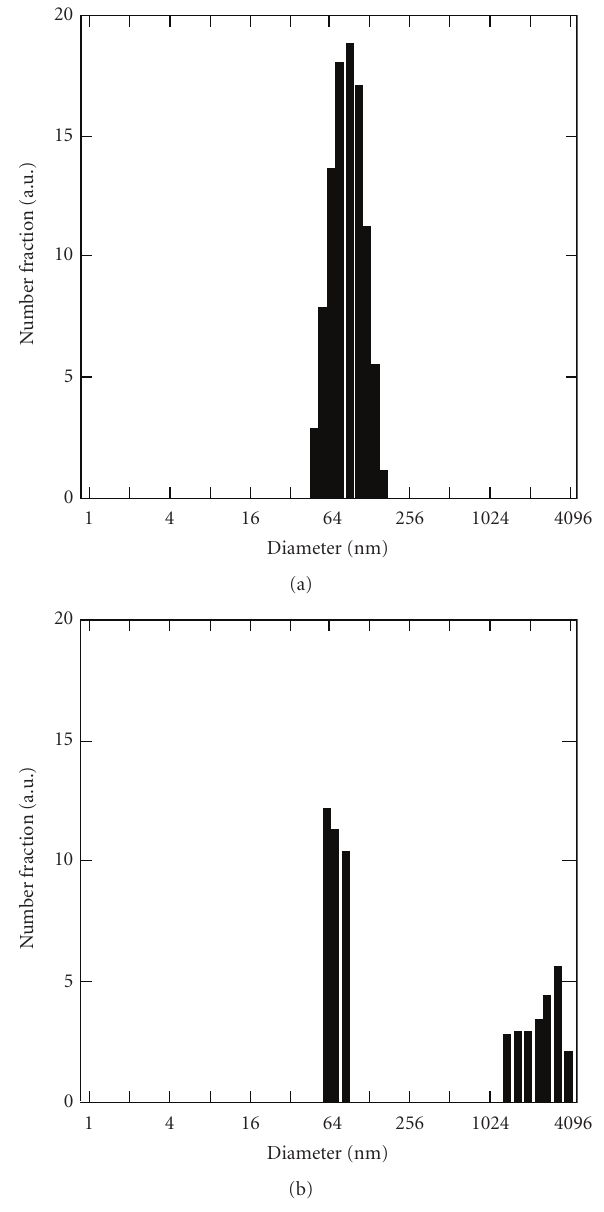
Figure 5: Size distribution of aggregates obtained from (a) diblock-type structure and (b) triblock-type structure. Copolymer: EG45L24, concentration: 1.0 g/L, temperature: 20 ◦